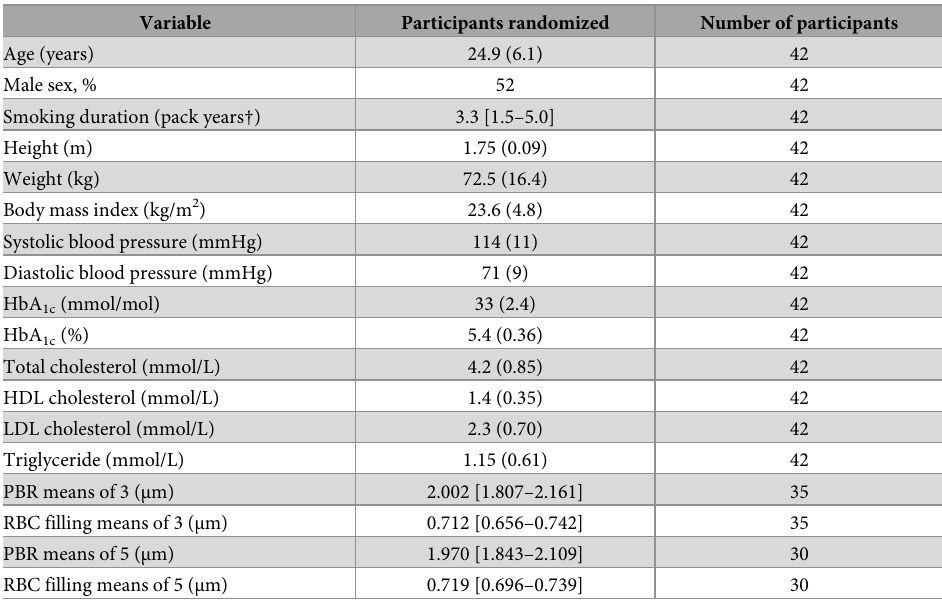
Table 1. Population